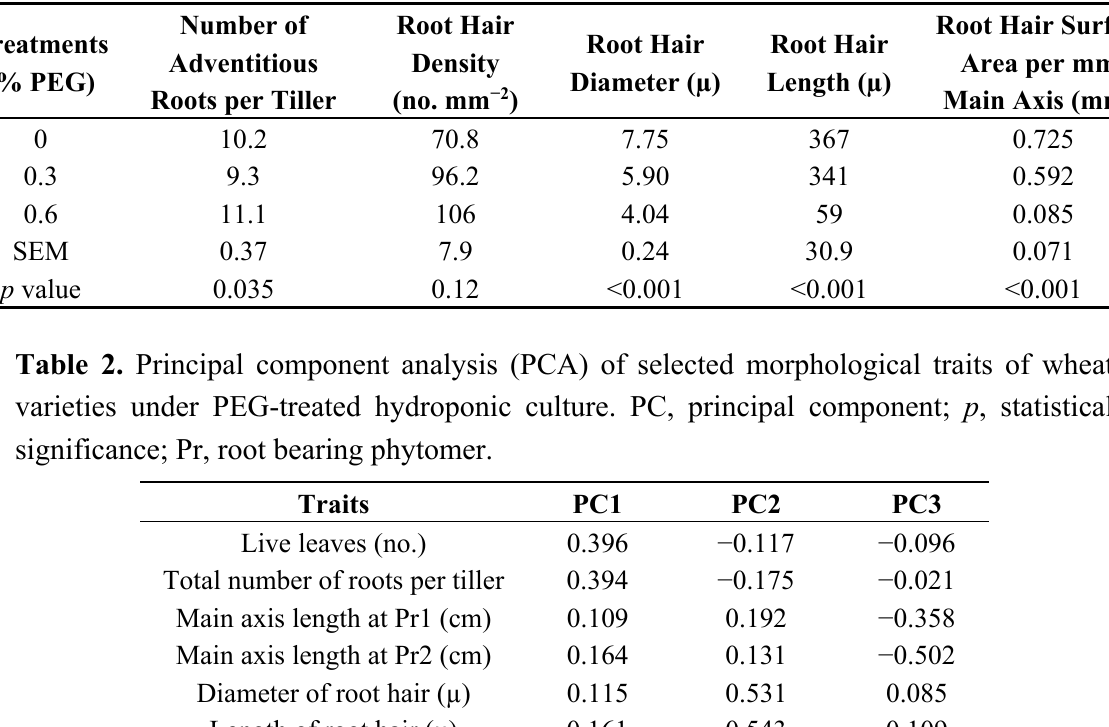
Table 1. Variation in morphological characters of 13 wheat varieties 20 days after treatment due to three different PEG treatments. Data represents average of 39 replicates under each treatment. SEM, standard error of mean; p, probability of statistical significance.